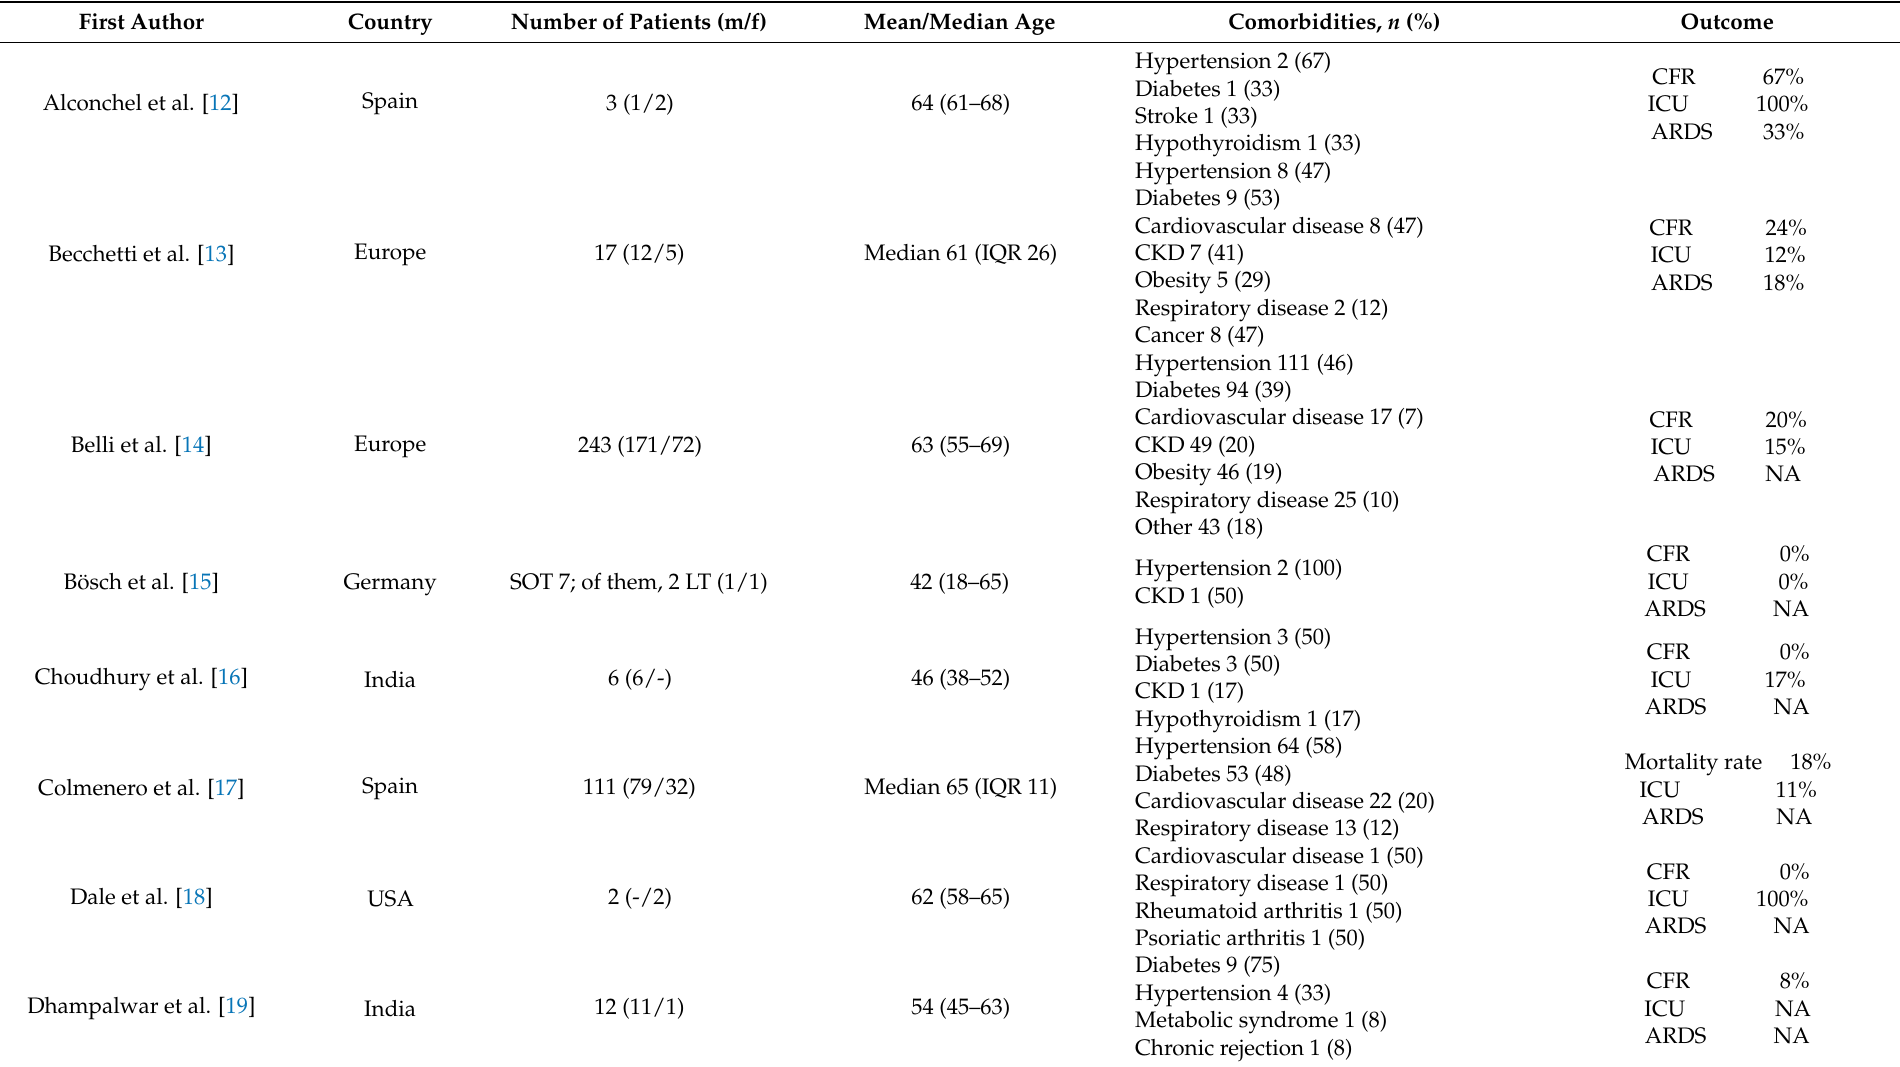
Table 1. General characteristics of the included